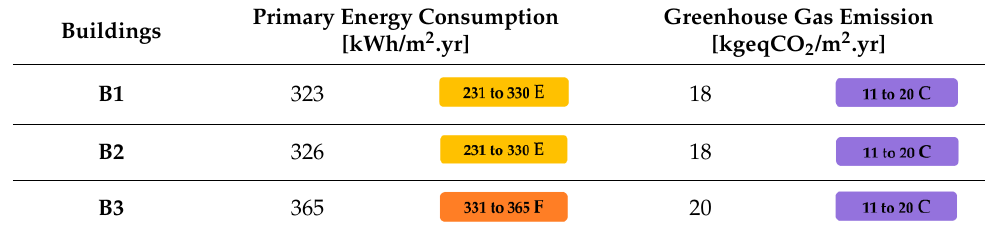
Table 2. Overall heat coefficients H . Table 2. Overall heat coefficients 𝐻 . Table 2. Overall heat coefficients 𝐻 . Table 2. Overall heat coefficients 𝐻 . Table 2. Overall heat coefficients 𝐻 . Table 2. Overall heat coefficients 𝐻 . Table 2. Overall heat coefficients 𝐻 .